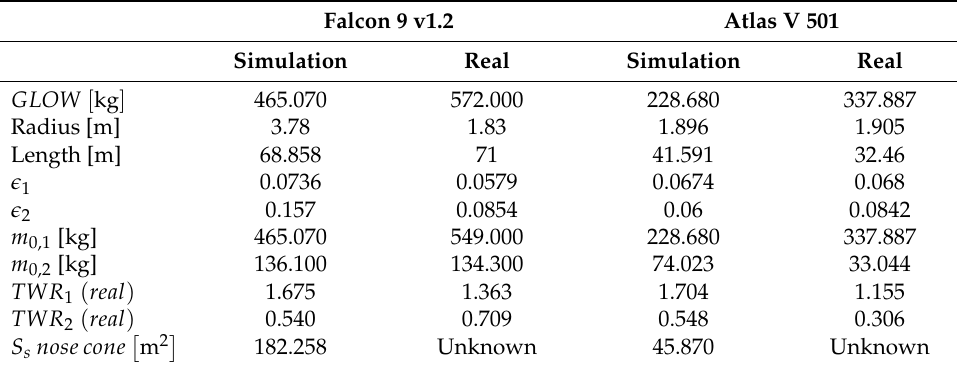
Table 7. Comparison of relevant quantities of the revised Falcon 9 v1.2 and Atlas V 501, with respect to the real